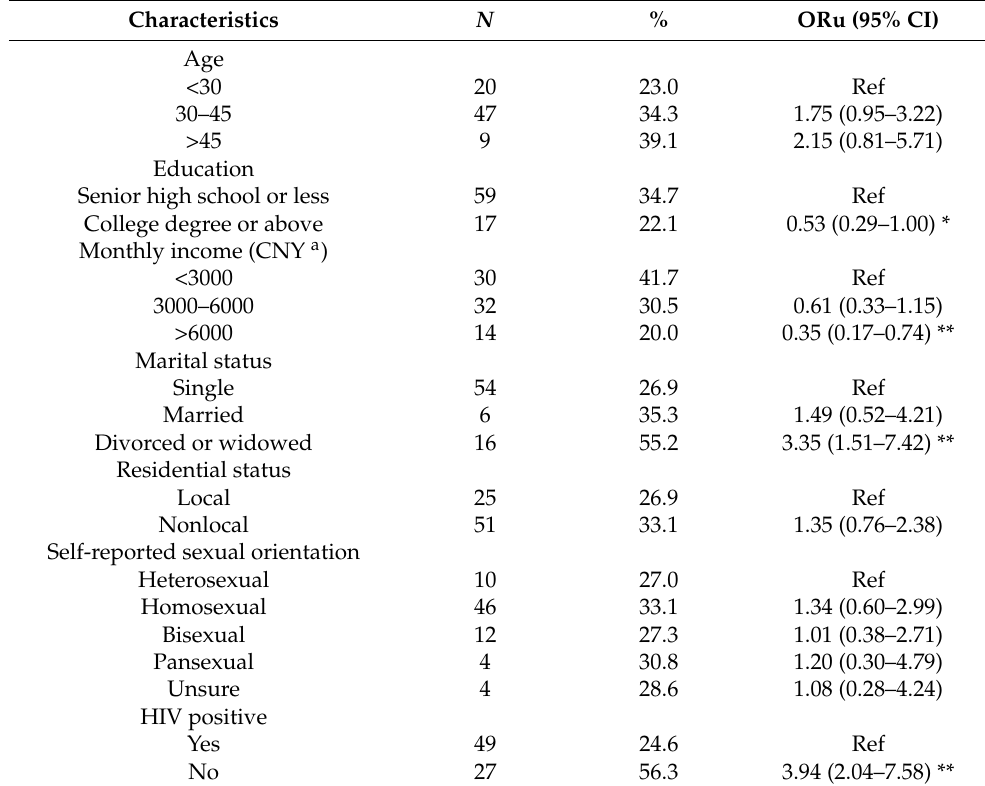
Table 2. Association between sociodemographic characteristics and CAS among transgender women ( N = 247).